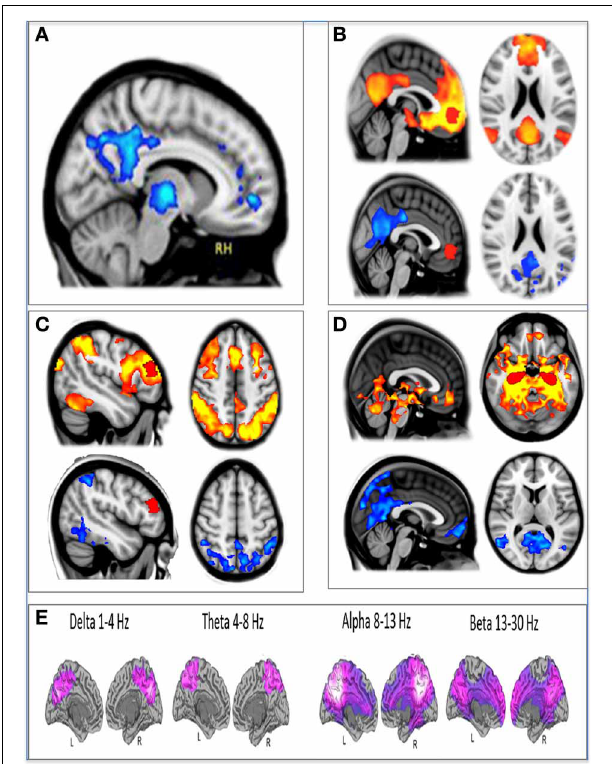
FIGURE 2 | The effect of psilocybin on fMRI and MEG measures of brain activity. (A) Decreased CBF post-psilocybin. (B) Ventromedial PFC (red) resting state functional connectivity (RSFC) at baseline (top, orange) and decreases post-psilocybin (bottom, blue). (C) Dorsolateral PFC (red) RSFC at baseline (top, orange) and decreases post-psilocybin (bottom, blue). (D) Hippocampal (red) RSFC at baseline (top, orange) and decreases post-psilocybin (bottom, blue). (E) Decreases in oscillatory power (purple) post-psilocybin measured with MEG. All spatial maps were whole-brain cluster corrected Z > 2 . 3. p < 0 .